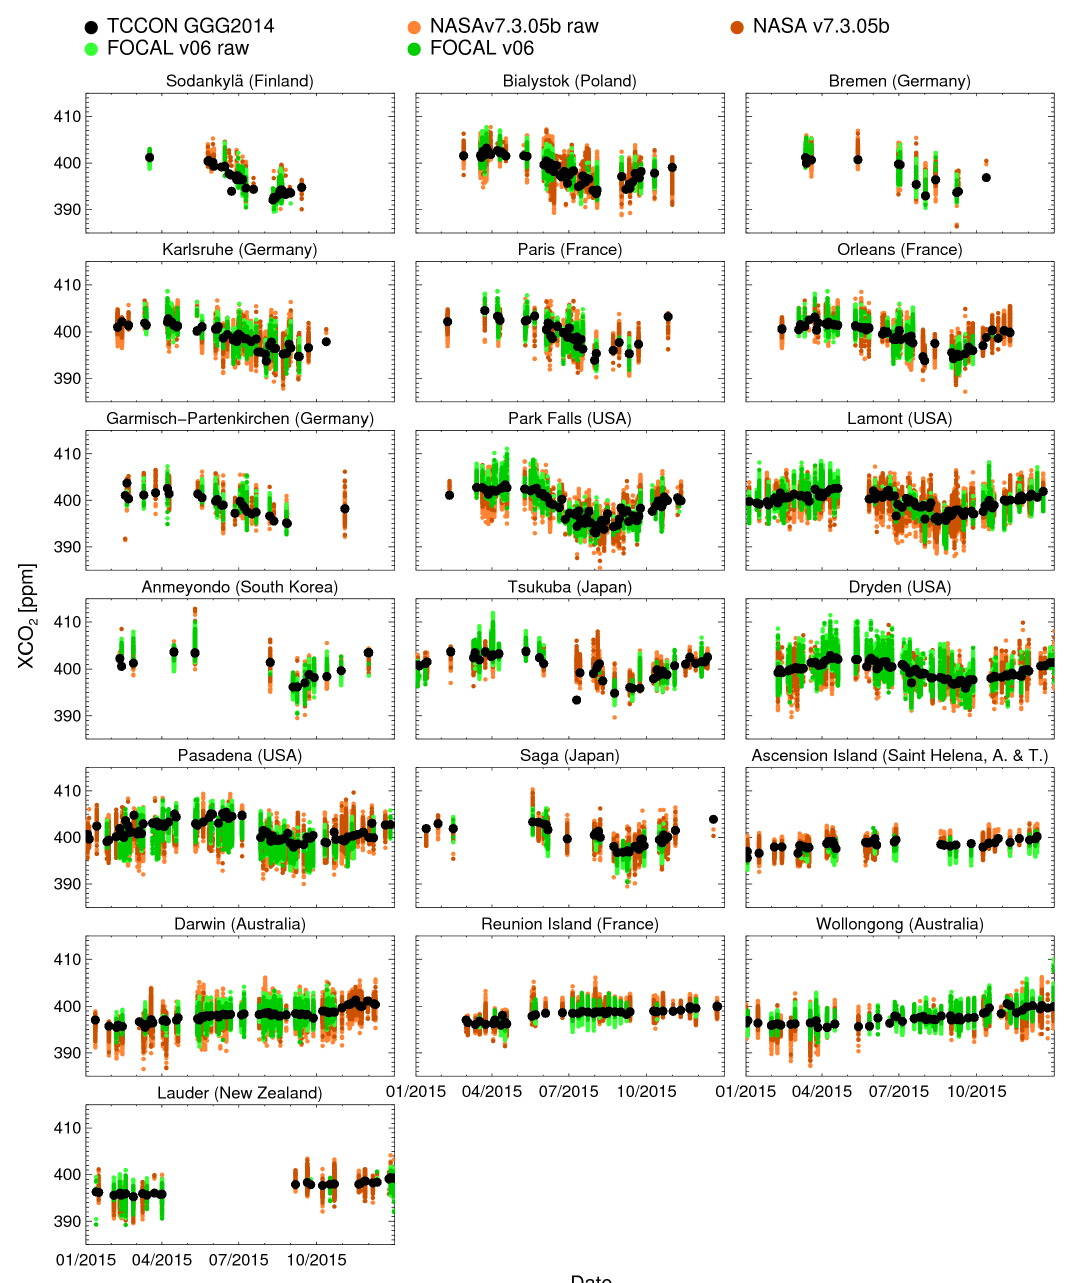
Figure 15. Validation of FOCALv06 and NASA’s operational OCO-2 L2 product (both with and without bias correction) with TCCON data from sites with more than 250 co-locations. The sites are ordered from north (top/left) to south (bottom/right): Sodankylä [34], Białystok [35], Bremen